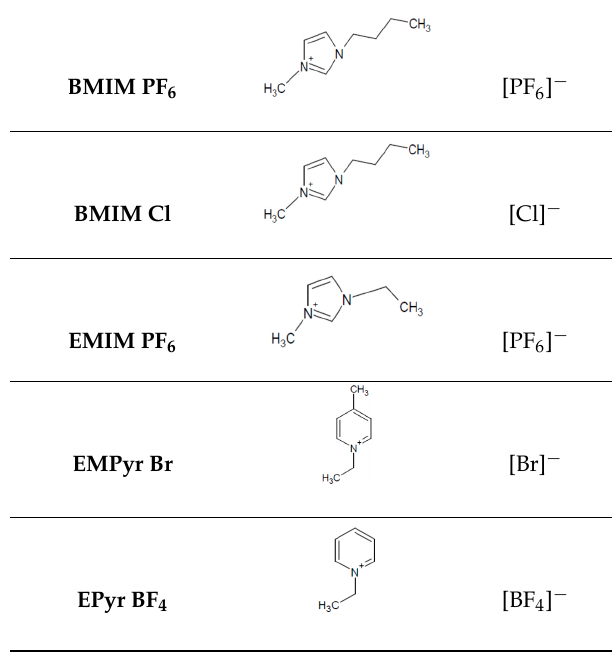
Table 1. Structures of the investigated ionic liquids.